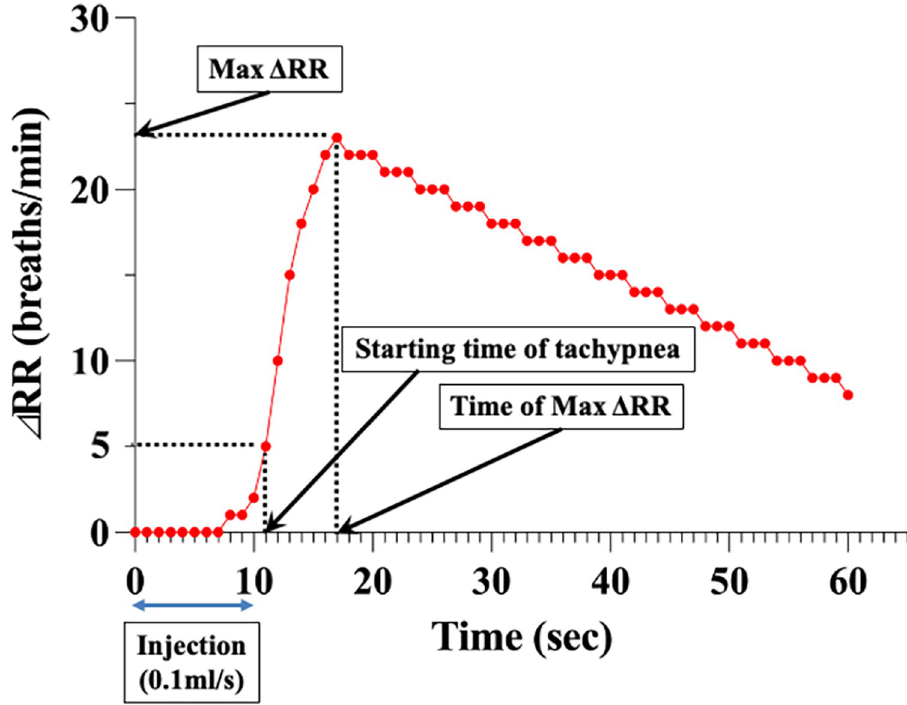
Fig 3. Definition of parameters related to the time course of the respiratory rate analysis. The starting time of tachypnea was defined as the time when the respiratory rate (RR) increased by more than 5 breaths/min compared to baseline (the time of the beginning of contrast medium injection). Max Δ RR was defined as the maximum value of Δ RR. Time of max Δ RR was defined as the time at which Δ RR reached its maximum value. In this manner, the starting time of tachypnea, max Δ RR and time of max Δ RR in individual rats are recorded and averaged for each experimental group. Note– Δ RR, change (increase) in the respiratory rate compared to baseline (0 sec; the time of the beginning of contrast medium injection). Starting time of tachypnea, the time when Δ RR reached 5